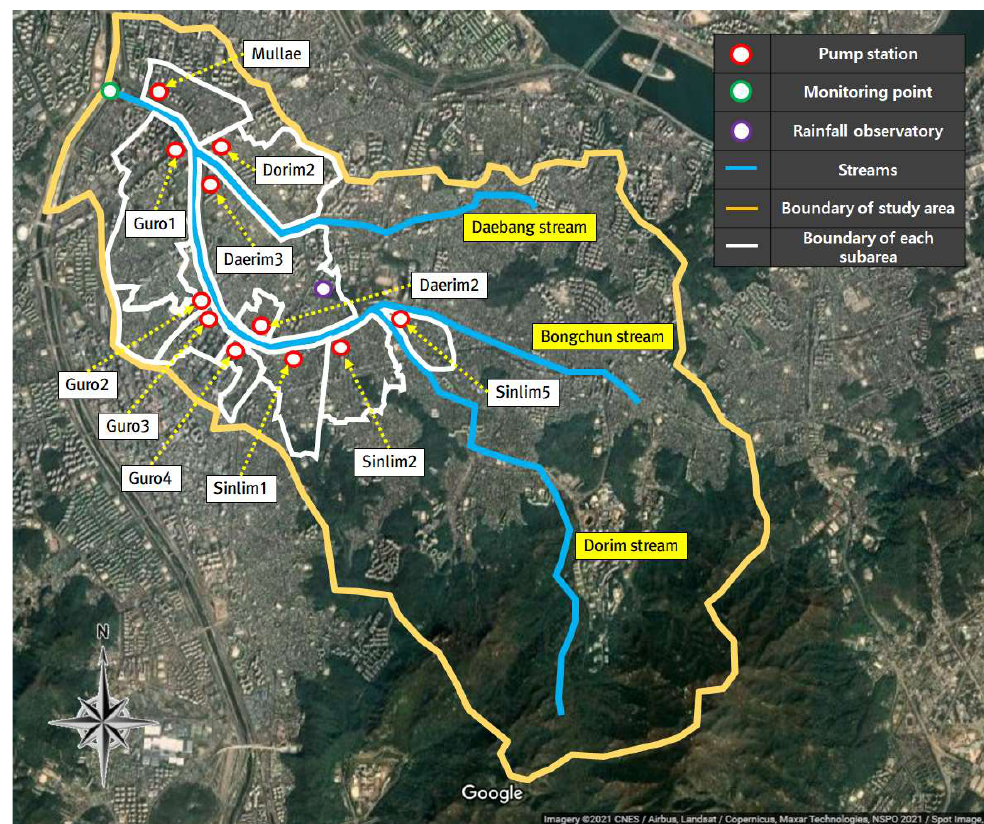
Figure 2. Information about the study area (Imagery © 2022 CNES/Airbus, Landsat/Copernicus, Maxar Technologies, NSPO 2021).